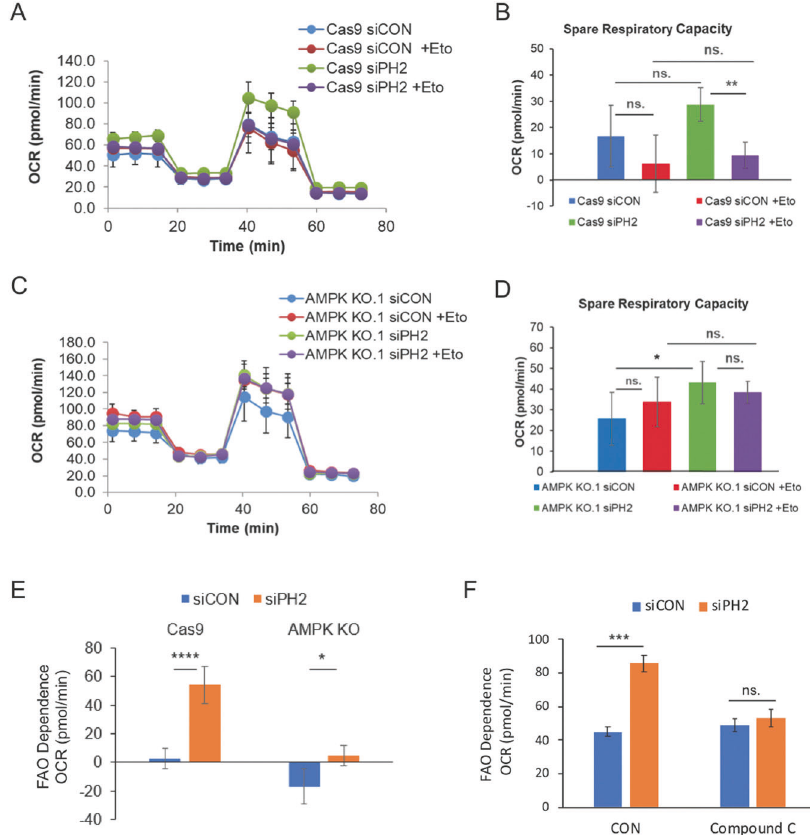
Fig. 5 PHLPP2 exerts its metabolic and apoptotic effects through an AMPK-ACC pathway. The contribution of fatty acid beta-oxidation (FAO) to mitochondrial respiration was determined using a Seahorse FAO assay. Cells were cultured in nutrient-limited medium a day